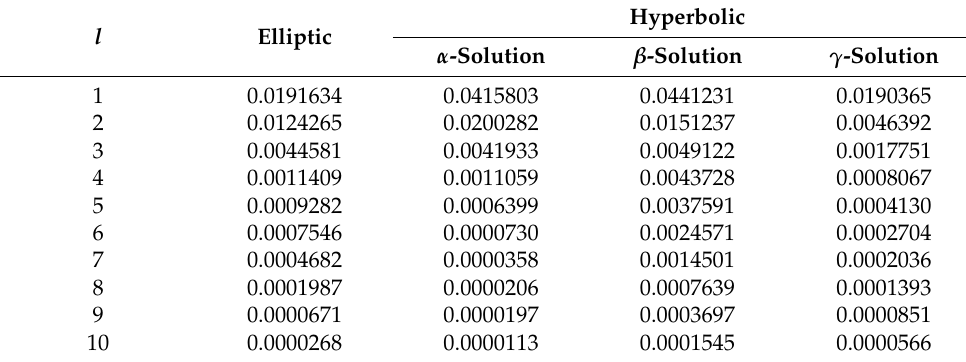
√ Table 6. The MSE of polynomial regression method of orders l = 1, . . . ,10 in estimating the critical collapse response function g ( z ) = arg f 0 ( z ) in elliptic and hyperbolic cases based on a training sample of size n =